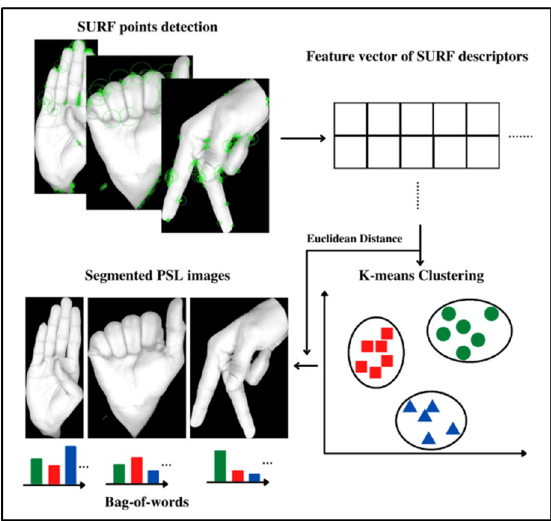
Figure 5. Bag-of-words generation.